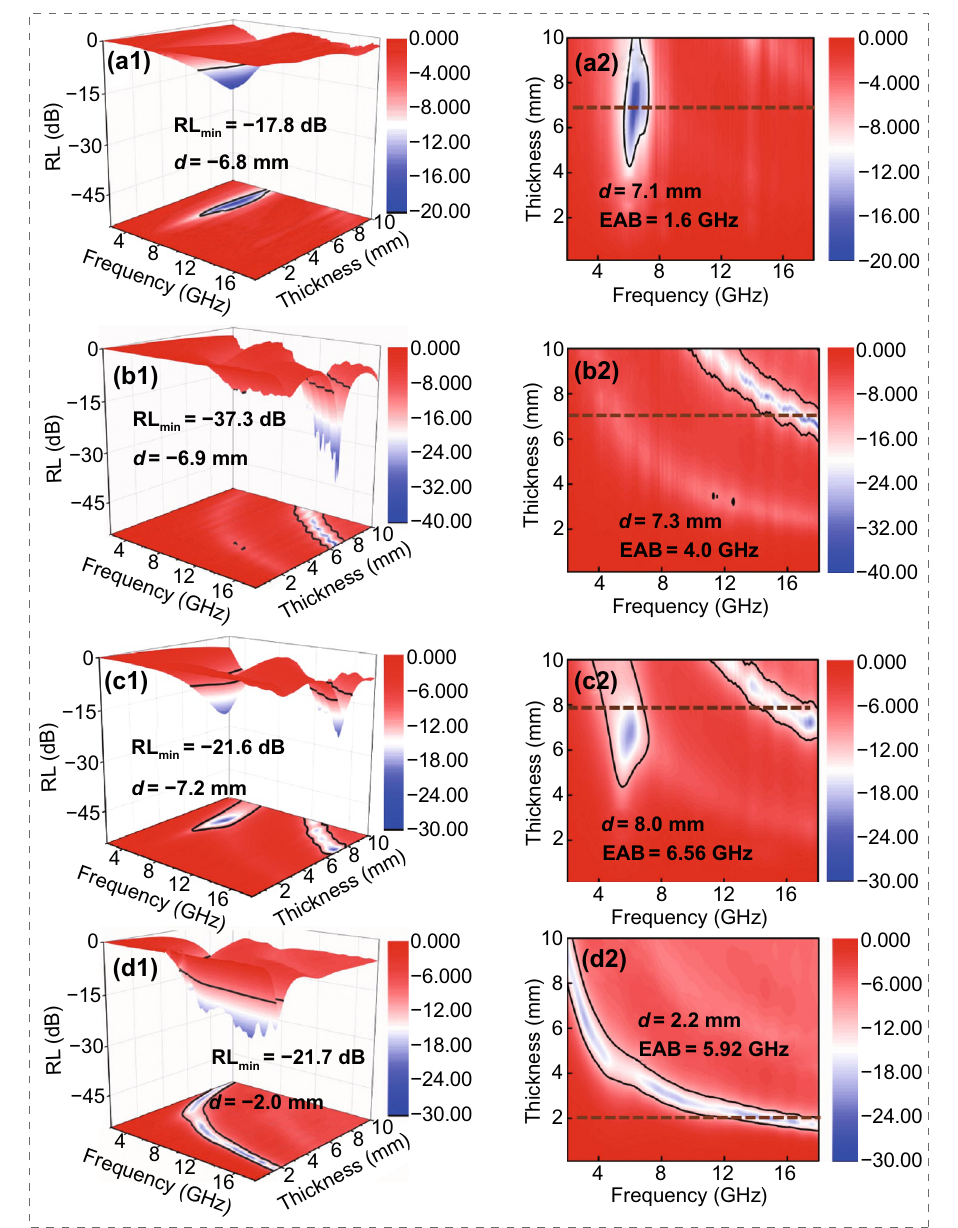
Fig. 5 3D reflection loss of CoSnO 3 /PAN ( a1 ), CNF ( b1 ), Co 3 SnC 0.7 /CNF-700 ( c1 ), Co 3 SnC 0.7 /CNF-900 ( d1 ); the 2D effective bandwidth of CoSnO 3 /PAN ( a2 ), CNF ( b2 ), Co 3 SnC 0.7 /CNF-700 ( c2 ), Co 3 SnC 0.7 /CNF-900 ( d2